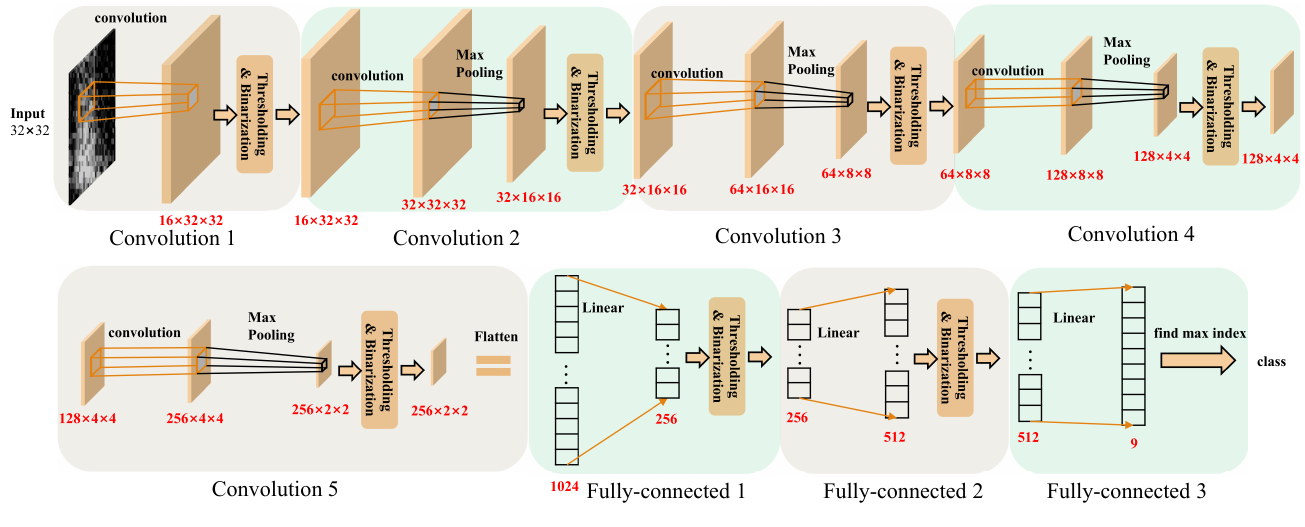
Figure 6. Architecture of BNN.